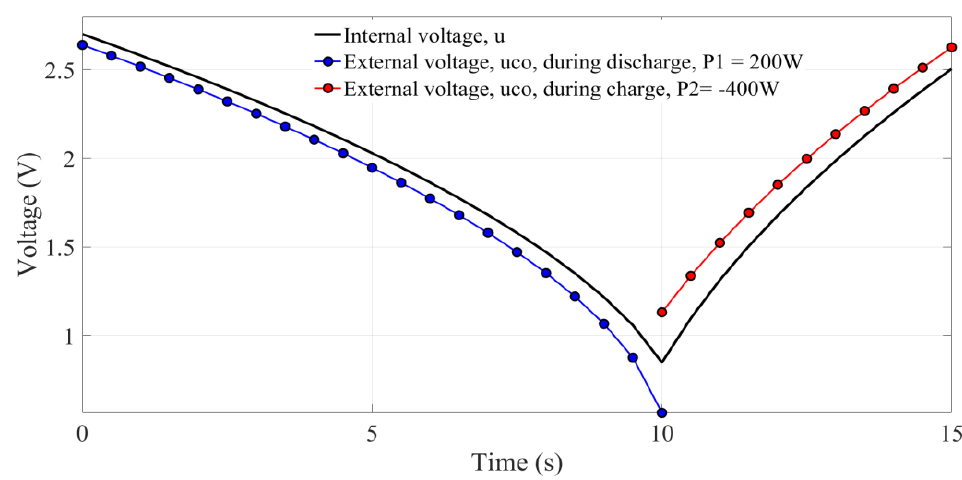
Figure 7. Evolution of variable g (cid:2869) over time.